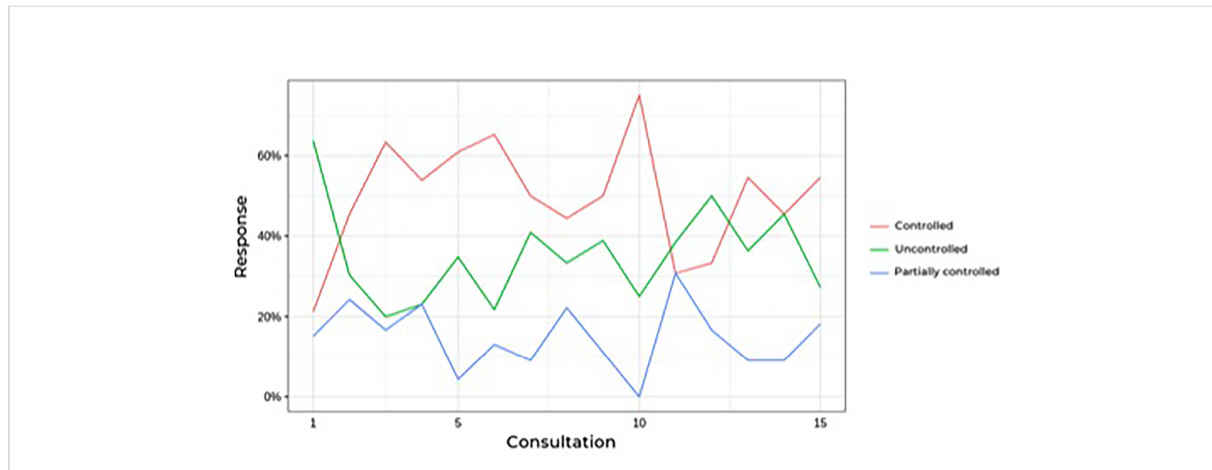
FIGURE 2 Prevalence of controlled hypercortisolism during follow-up of Cushing's disease patients treatesd with